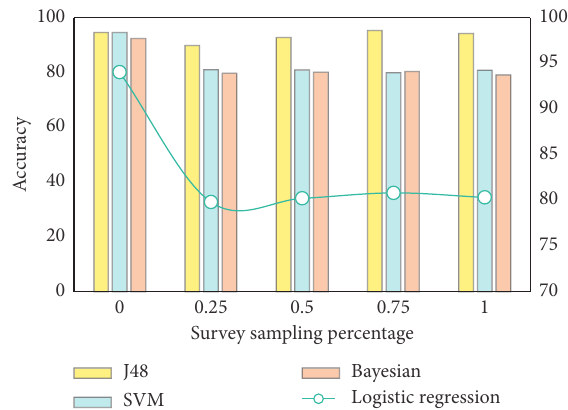
Figure 4: Comparison of accuracy